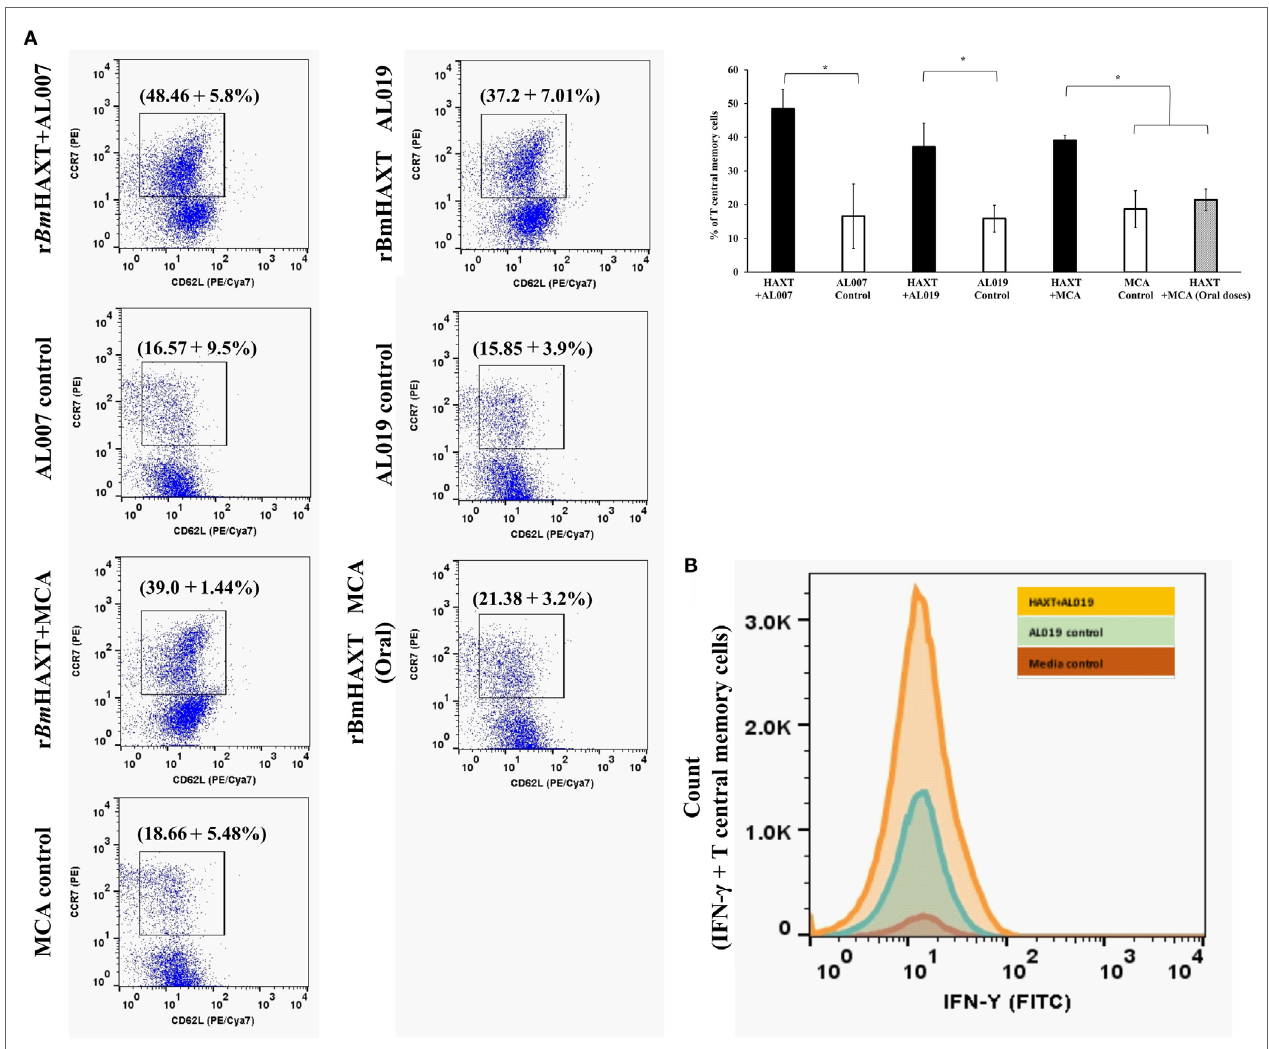
FigUre 6 | T-central memory cells and their IFN- γ secretion in the spleen of immunized mice. (a) Cultured spleen cells were stained with anti-mouse CCR7 (PE) and CD62L (PE/Cya7) antibodies. Cells which were dual positive for both the markers were selected as T central memory cells. Results showed that, T central memory cells were significantly high in r Bm HAXT + AL007 compared to all the groups. Similarly, r Bm HAXT + mannosylated chitosan (MCA) and r Bm HAXT + AL019-treated mice also showed significant increase in T central memory cells. (B) Histogram showed that r Bm HAXT + AL019 formulation-treated animals showed significantly increased expression of IFN- γ in T central memory cells. However, no significant difference was found in r Bm HAXT plus Al007/ MCA-treated groups with respect to their respective control group. * p < 0.05 compared to respective group as analyzed by Kruskal-Wallis test followed by Bonferroni correction for multiple